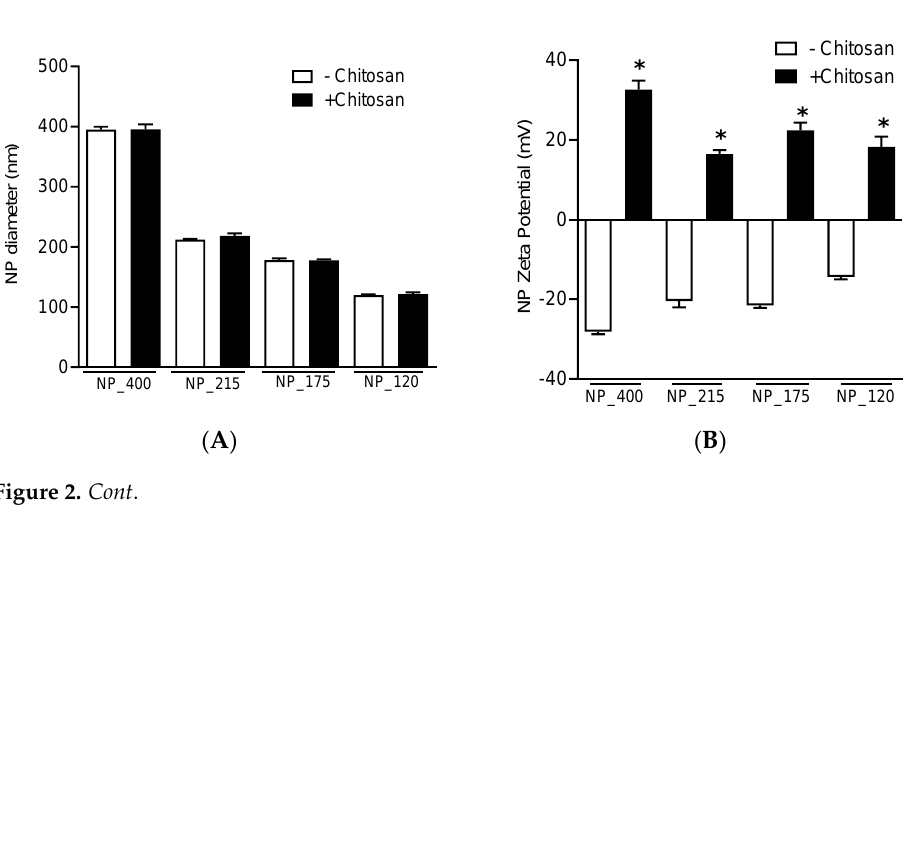
Figure 1. Graphical schematic of experimental design. Organic solvent ( A ) containing PLGA and simvastatin was added to aqueous emulsifying solution ( B ) containing PVA ± chitosan, sonicated ( C ), and poured into aqueous evaporating solution ( D ) containing PVA ± chitosan for removal of organic solvent overnight. NPs were collected by centrifugation ( E ), lyophilized, and eight formulations were characterized ( F ). Key formulation parameters included the organic solvent and co-solvent ratio (i), the concentration of polymer in the organic phase (ii), the composition of the aqueous phases (iii), and the sonication amplitude (iv).